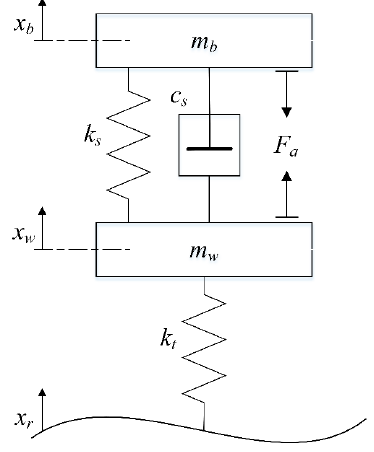
Figure 3. Vertical quarter-car model.